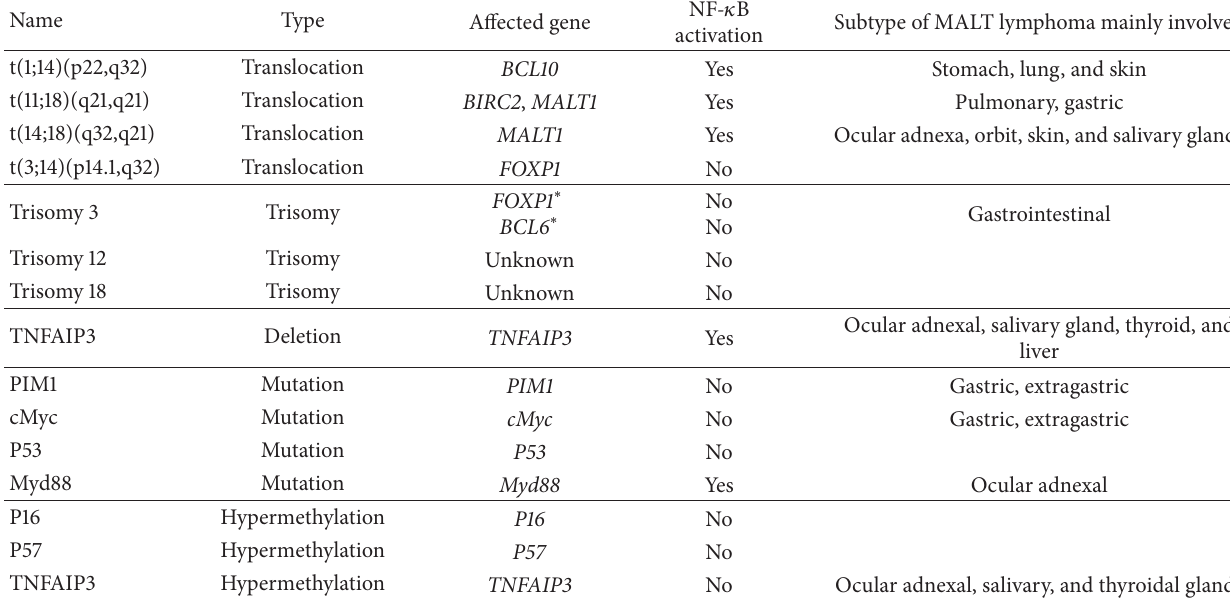
Table 1: Genetic alterations in MALT